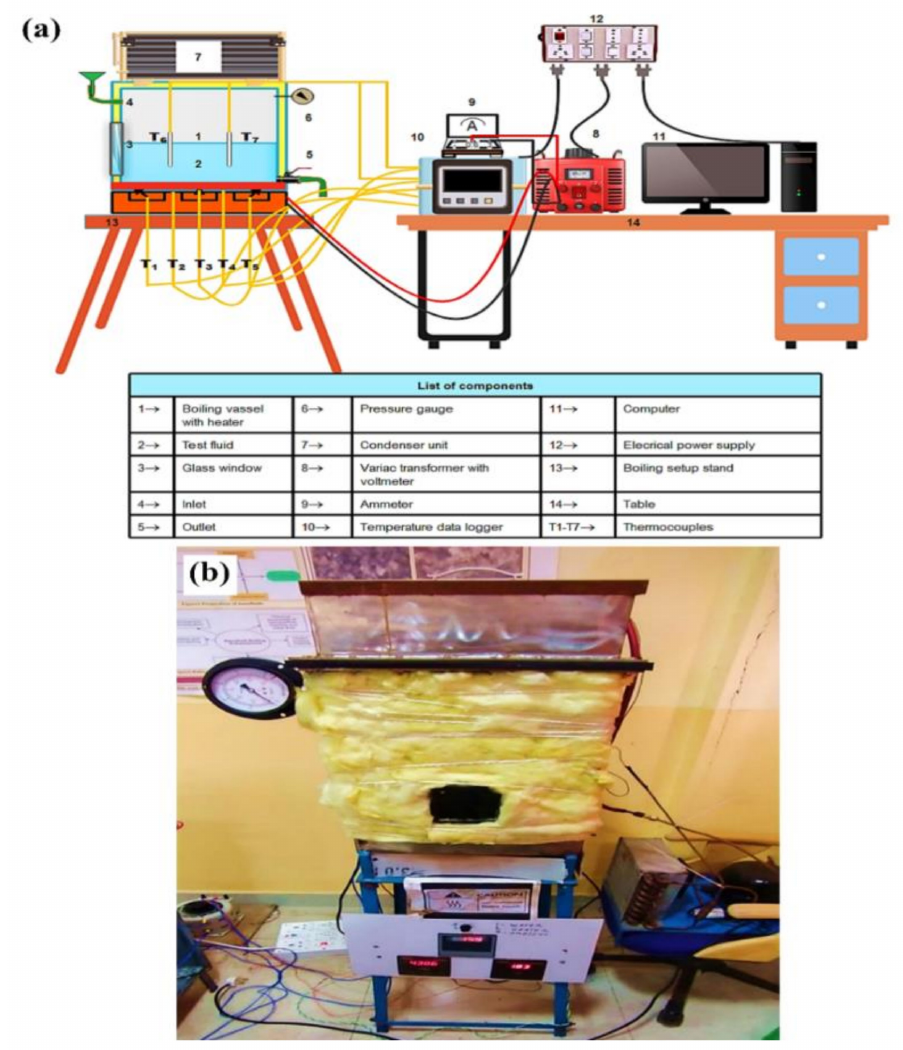
Figure 1. Experimental test rig, where ( a ) demonstrates the schematics design and ( b ) illustrates the actual